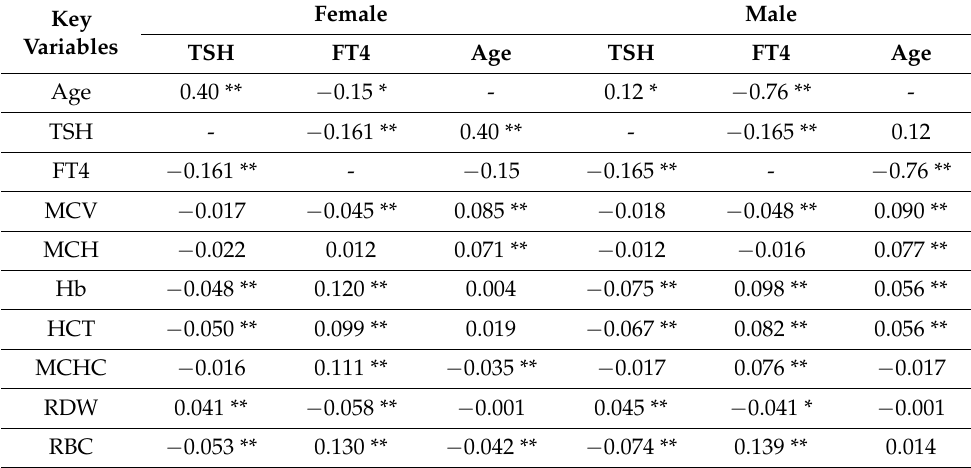
Table 6. A correlation coefficient of key variables based on